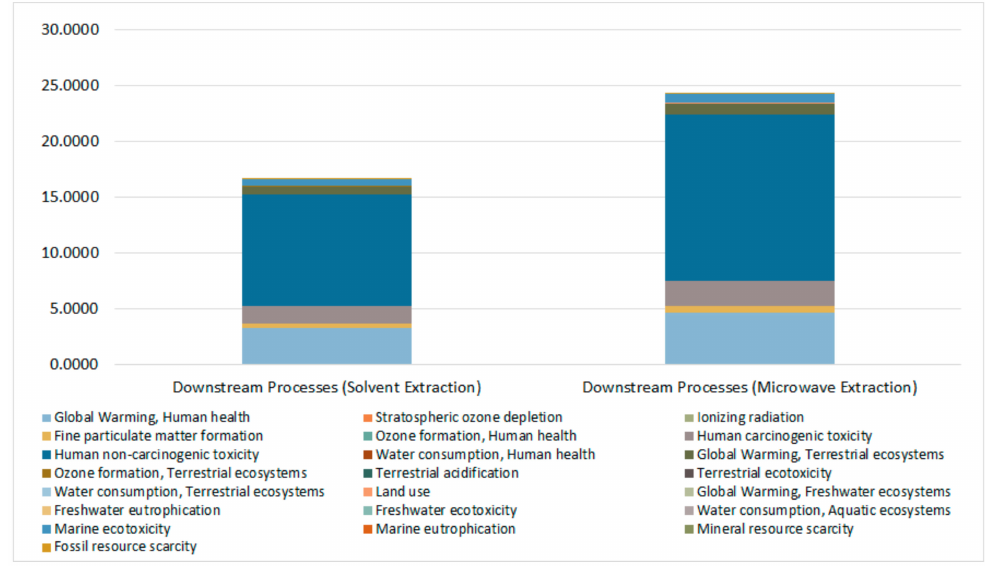
Figure 3. Life cycle environmental impacts of each downstream process path for 1 kg biodiesel.